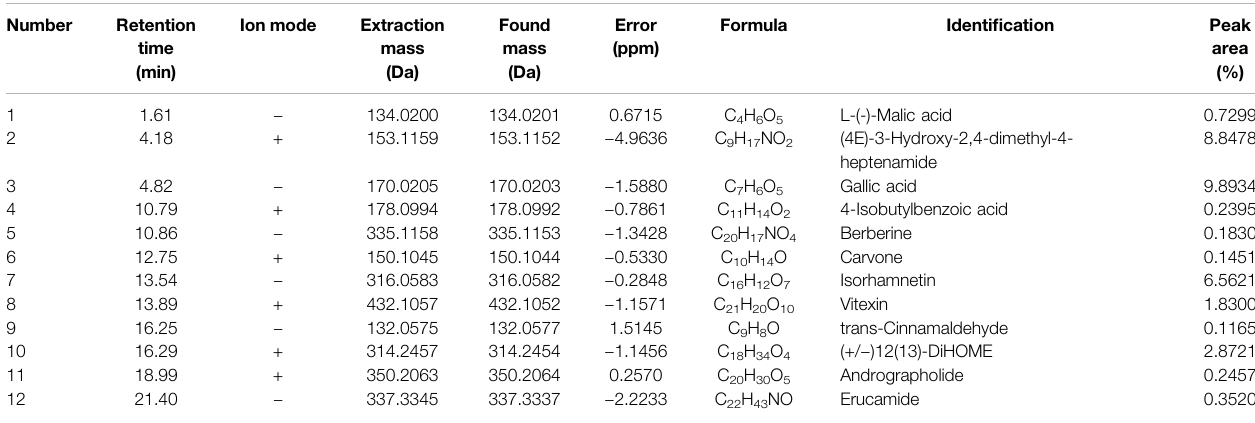
TABLE 2 | Identi fi cation of the chemical constituents in